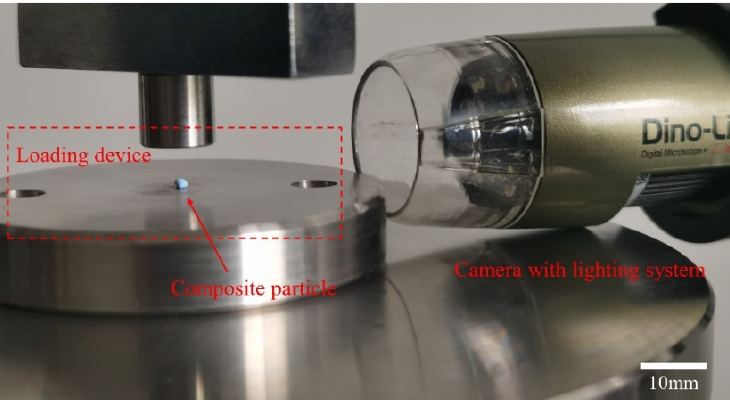
Figure 3. Light uniaxial loading device with a high-definition